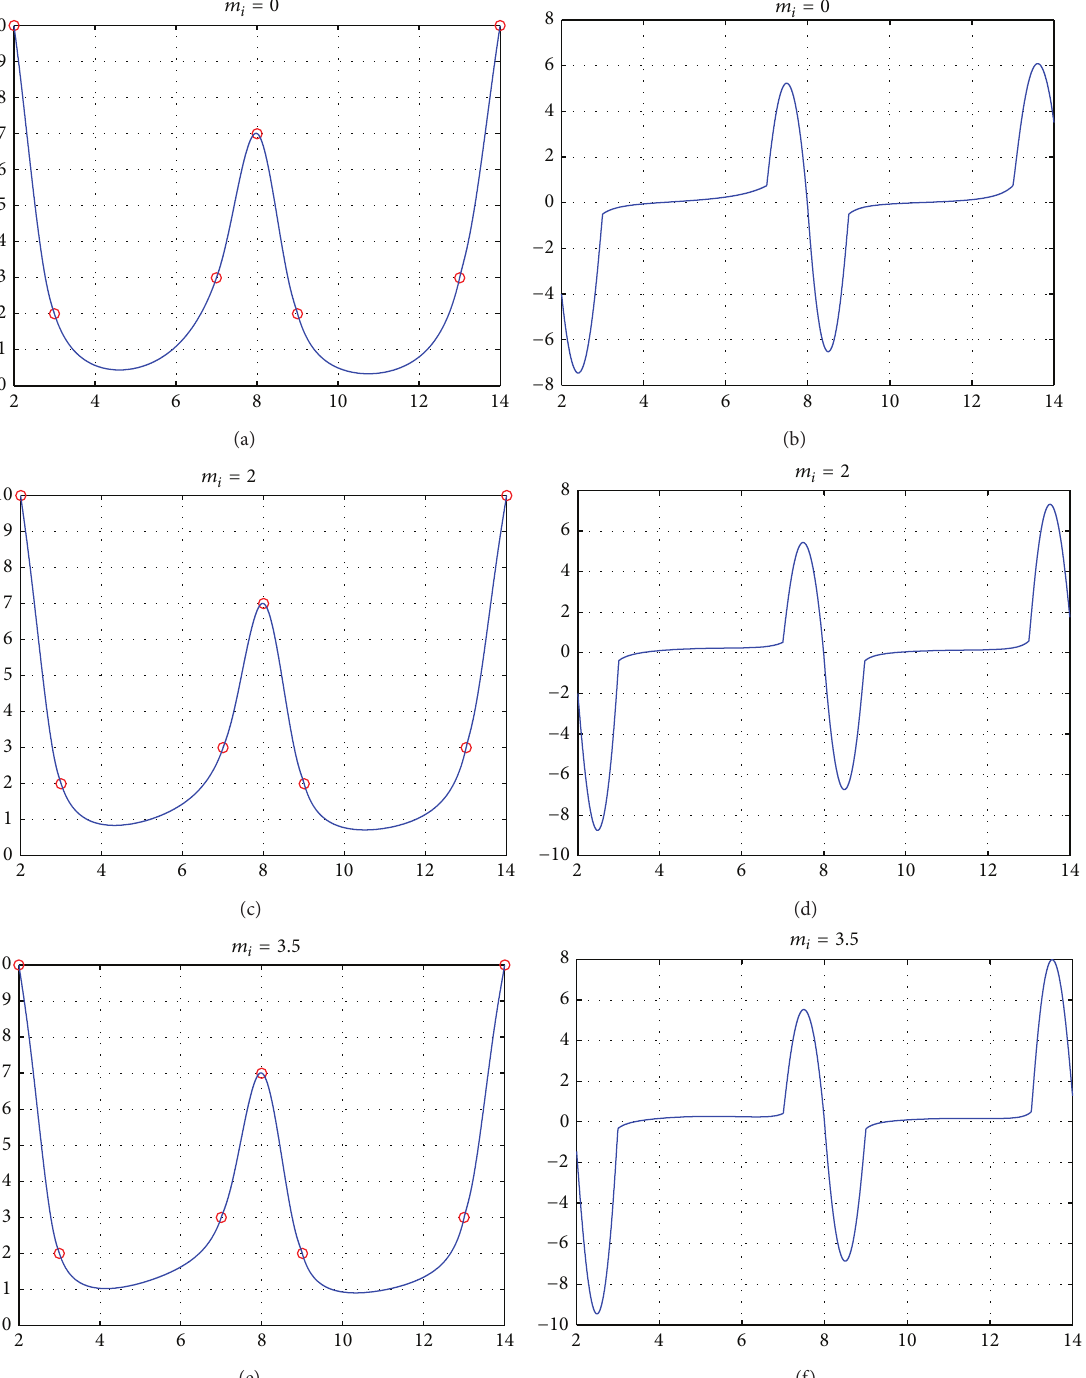
Without loss of generality, we just consider the function 𝐻(𝑥) constrained on the subinterval [𝑥 direct computation gives